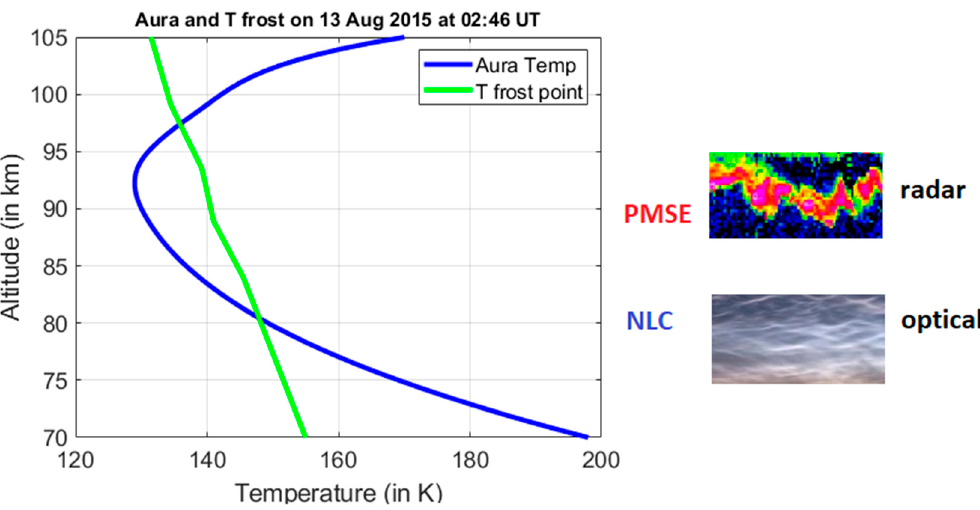
Figure 2. The temperature profiles (blue line) as measured by the Aura satellite [15] and frost point temperature profiles (green line) estimated using the Aura water vapor data [16]. The height ranges in which the temperature is lower than the frost point temperature indicate the regions of formation and existence of ice particles around the summer mesopause. These profiles were obtained on a day when both PMSE and NLC were observed.